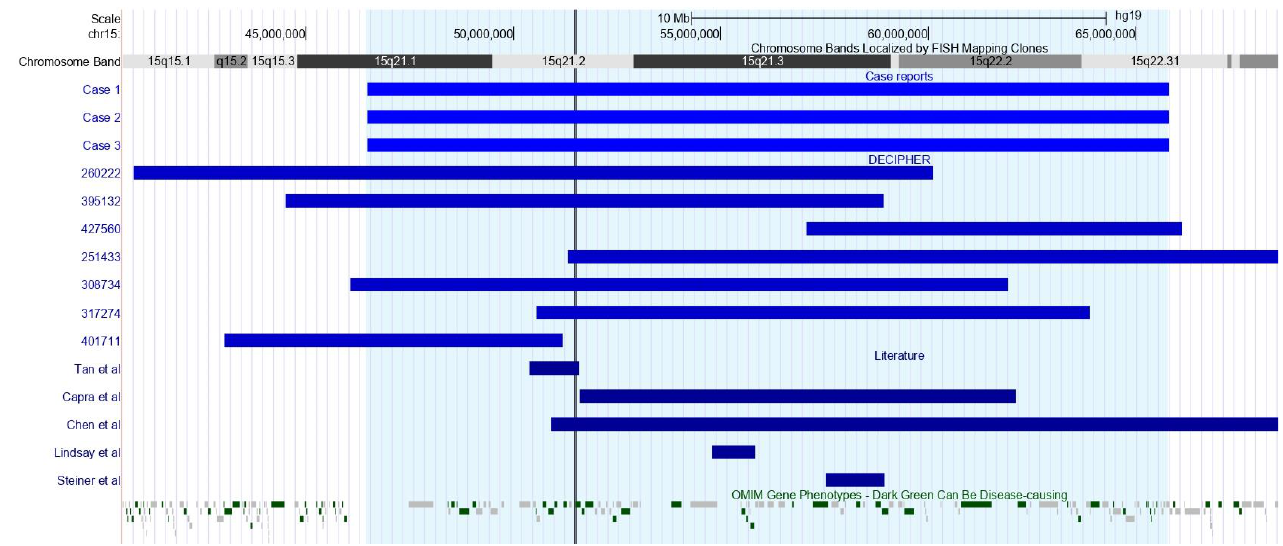
Figure 4. View of the 15q15.1-q26.3 region, including duplications, represented by blue bars, from the present subjects and cases from DECIPHER and literature. The CYP19A1 gene region is highlighted by the black vertical line. Image taken from UCSC Genome Browser on Human (GRCh37/hg19).